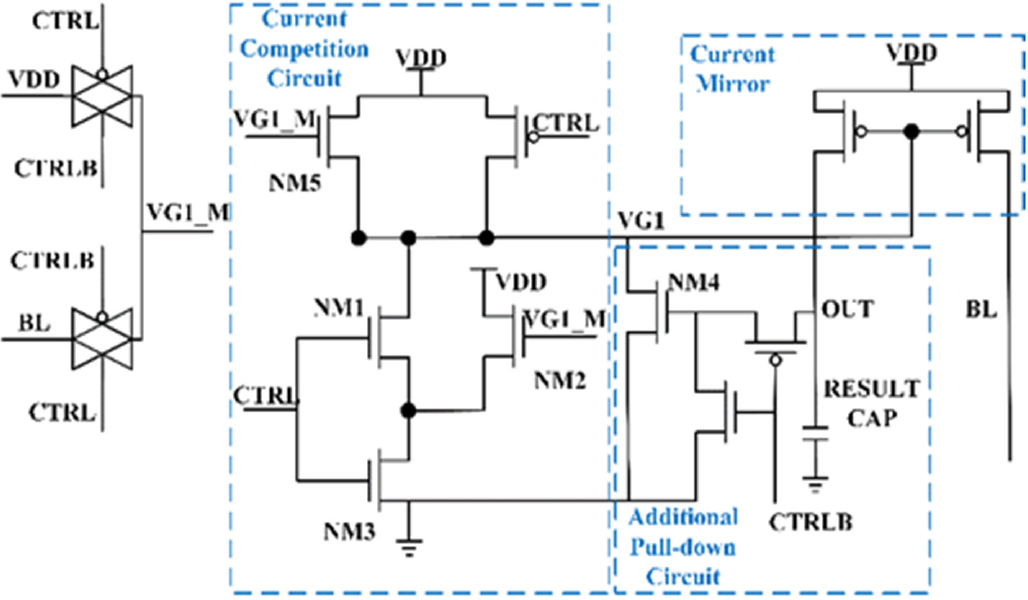
Figure 1. Schematic of the proposed low computing leakage, wide-swing output compensation circuit.